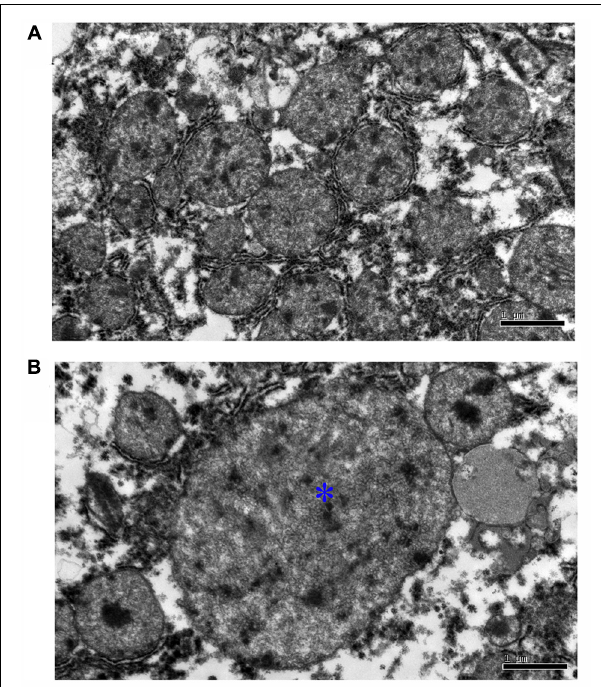
FIGURE 1 | Ultrastructural pathological analysis of mitochondrion in Mongolian gerbil livers. (A) No apparent pathological change was observed in the mitochondrion in control group. (B) The mitochondria were considerably swollen and were shown to have thin cristae ( ∗